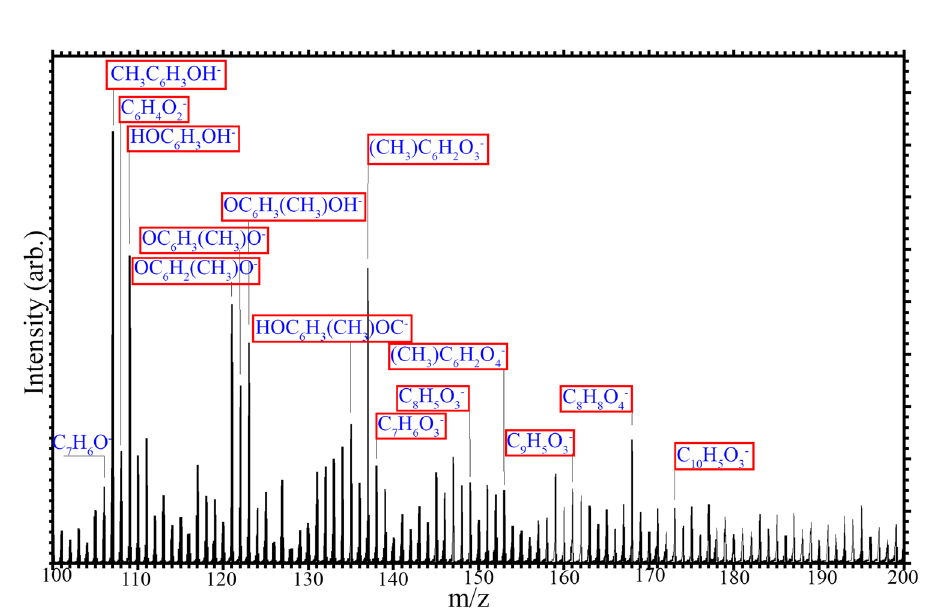
Figure 4. The ToF–SIMS results with negative polarity of an m-cresol film produced with a 1 min plasma exposure, with fragments highlighted in red that suggest oligomerisation or polymerisation of